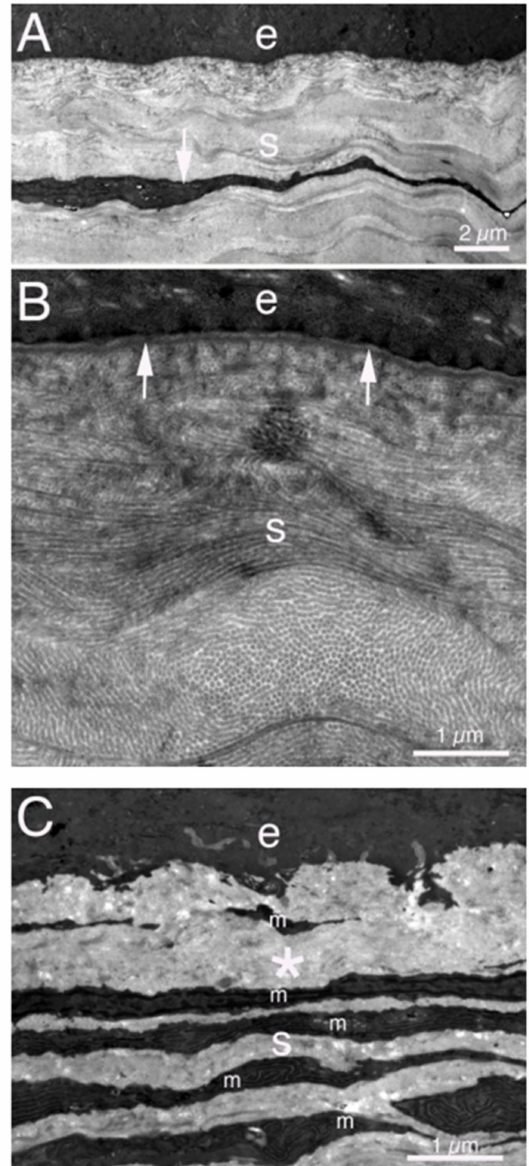
Figure 3. TEM of normal and fibrotic rabbit corneas. ( A ) Lower magnification image of an un- wounded cornea showing the epithelium (e) and stroma (s) with a keratocyte (arrow). ( B ) Higher magnification image showing the epithelium (e) with the underlying EBM. The arrows indicate the lamina lucida anterior to the lamina densa of the EBM. In the stroma (s) note the uniform diameter of the collagen fibrils, with some seen in cross-section and others longitudinally, and the highly ordered packing of the fibrils. ( C ) In a cornea with severe fibrosis at 1 month after PRK, the stromal ECM is highly disorganized (*), without evidence of regular fibrils or packing. The anterior stroma (S) is